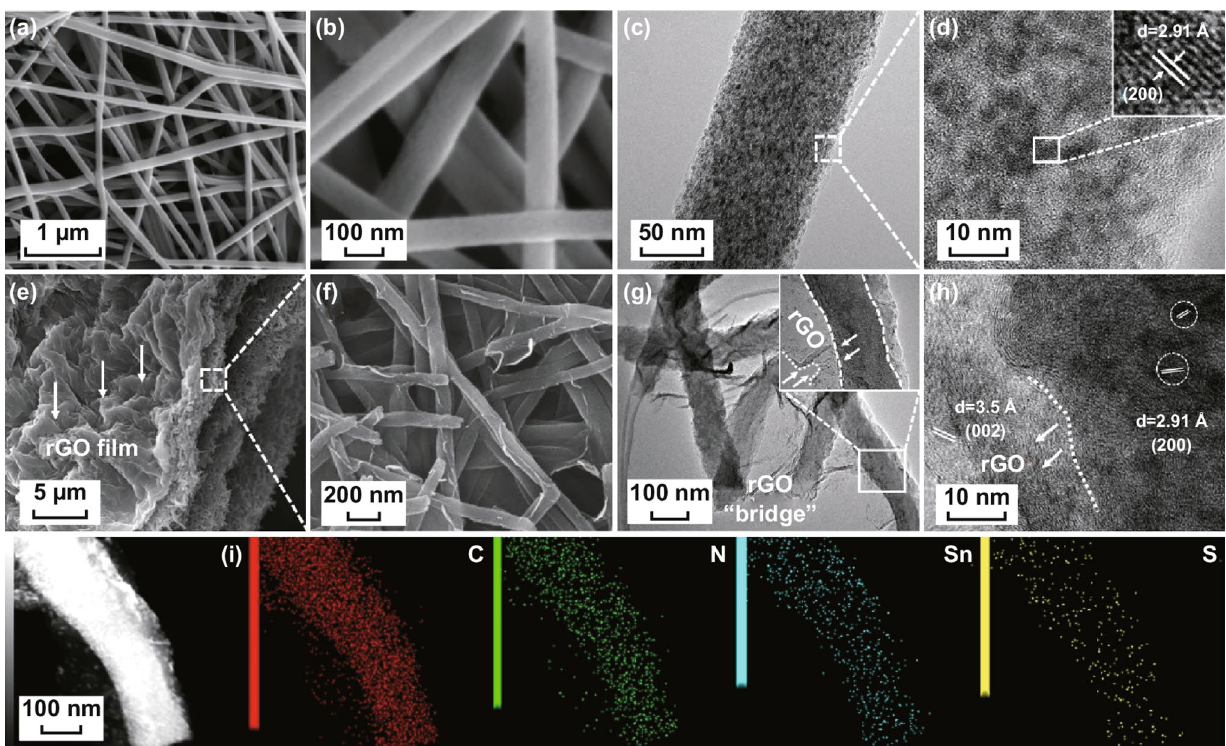
Fig. 2 Morphology and microstructure characterizations of Sn/N‑CNFs and Sn/NS‑CNFs@rGO. a , b SEM images of Sn/N‑CNF; c TEM and d HRTEM images of Sn/N‑CNFs. e Low‑magnification and f high‑magnification SEM images of Sn/NS‑CNFs@rGO. g TEM and h HRTEM images of Sn/NS‑CNFs@rGO. i Dark‑field image of the Sn/NS‑CNFs@rGO and the corresponding EDS elemental mapping of C, N, Sn, and S, illustrating homogeneous distribution of C, N, Sn, and S atoms along the nanofiber